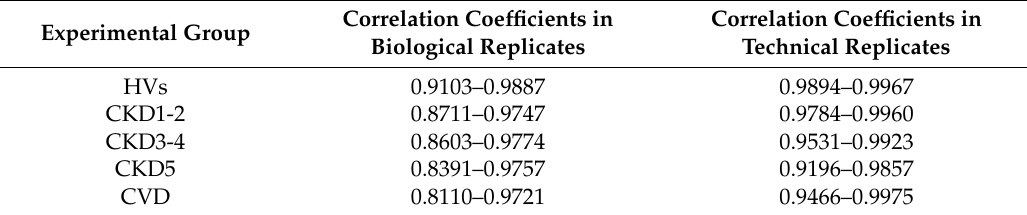
Table 1. Pearson correlation coefficients between the LFQ (label-free quantification) intensities from the biological and technical replicates in all experimental groups. The calculations were derived from Perseus software. HV refers to healthy volunteers, CKD refers to chronic kidney disease (numbers indicate disease stages), and CVD refers to cardiovascular disease.